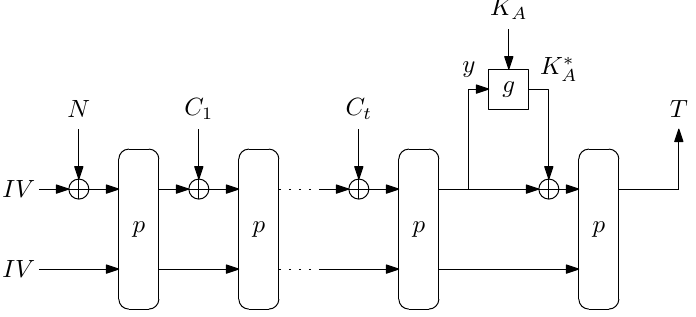
Figure 7: Sketch of authentication/verification just using a sponge-based suffix